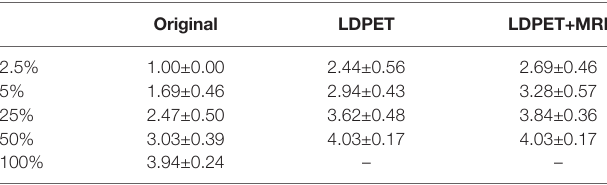
TABLE 2 | Mean clinical quantitative scores from nuclear medicine doctors on LDPET images, synthesized FDPET images, MR prior-synthesized FDPET images, and target